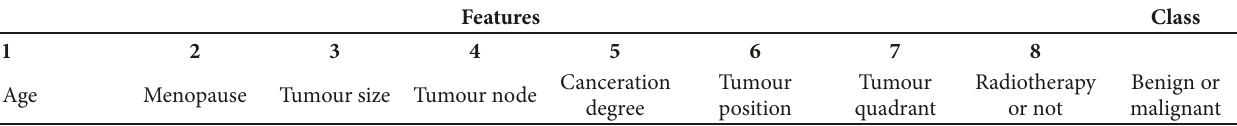
Table 2: The 8 features and classes of dataset